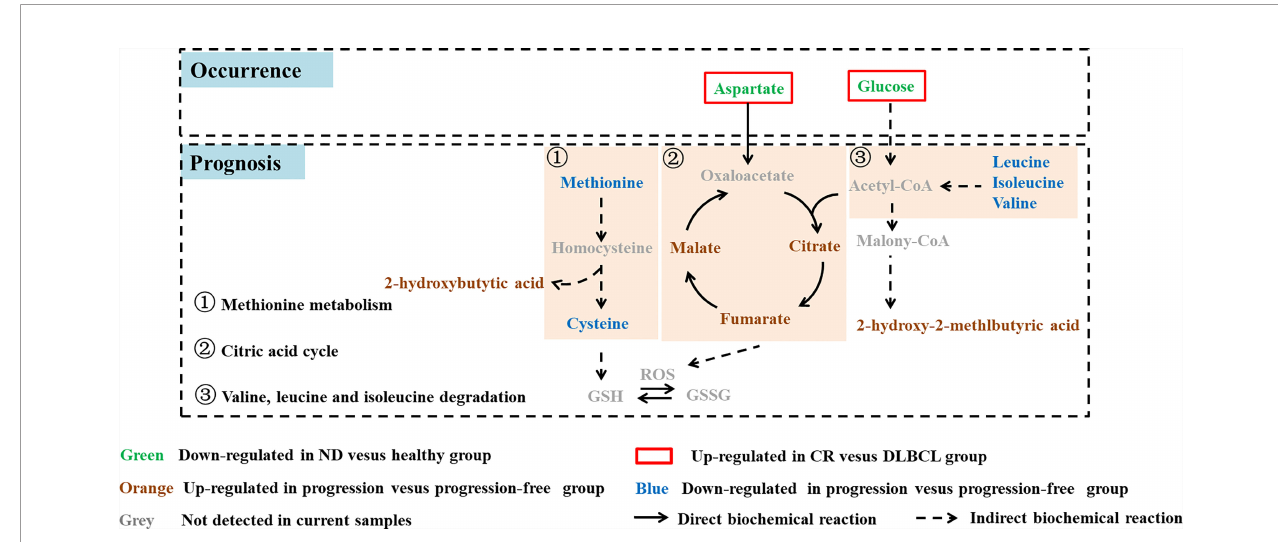
FIGURE 5 | Typical metabolites and associated pathways perturbed in DLBCL